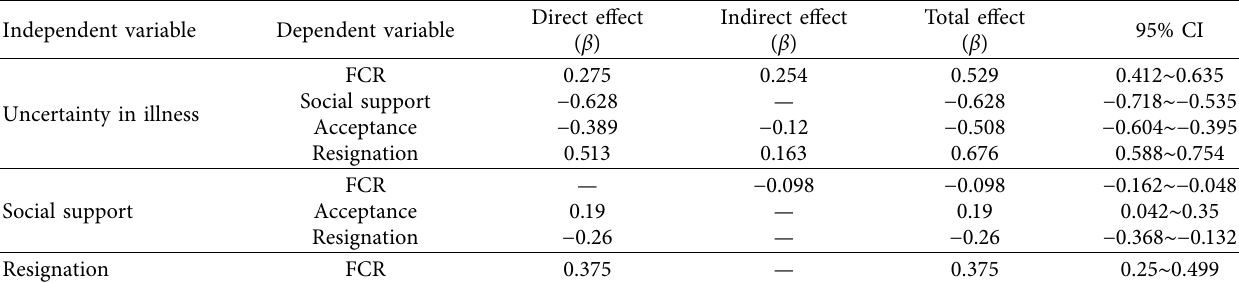
Table 5: Analysis of efect of FCR infuencing factors in breast cancer